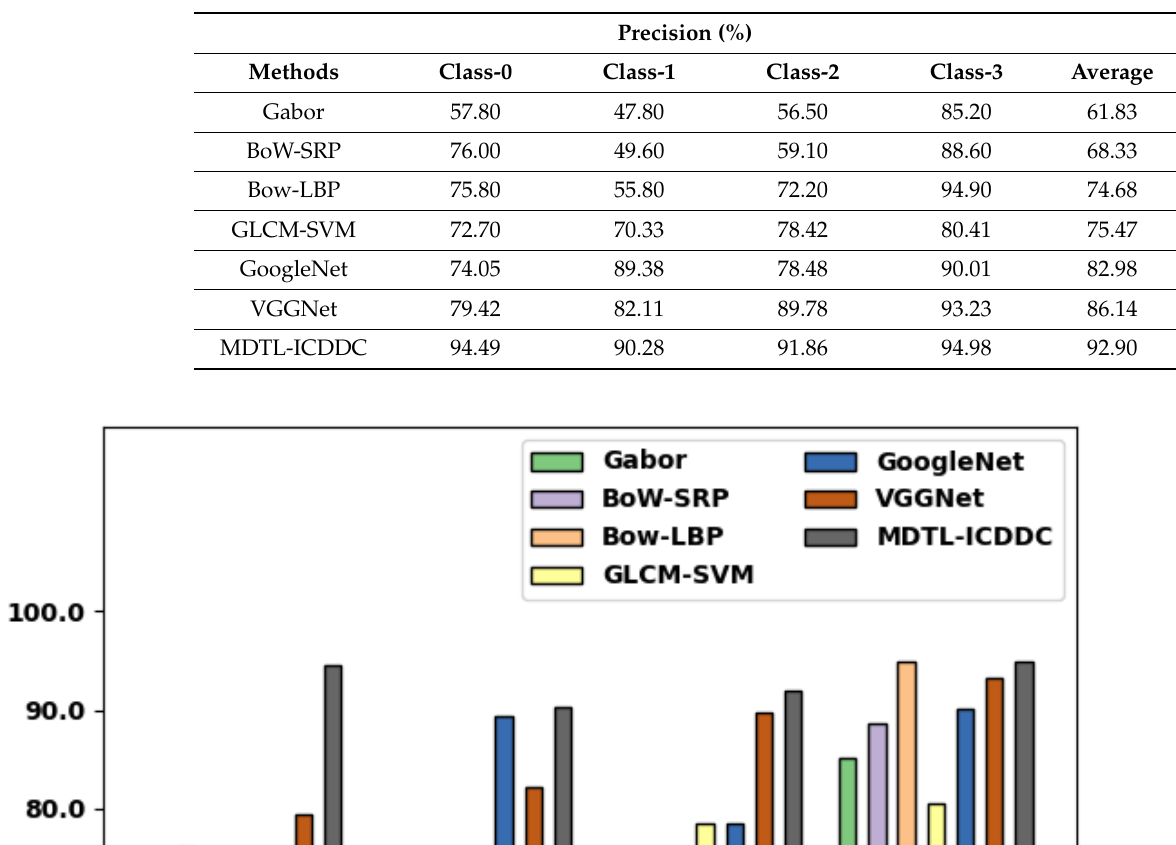
Table 3. Precision analysis of MDTL-ICDDC technique with existing algorithms under various clas- ses.